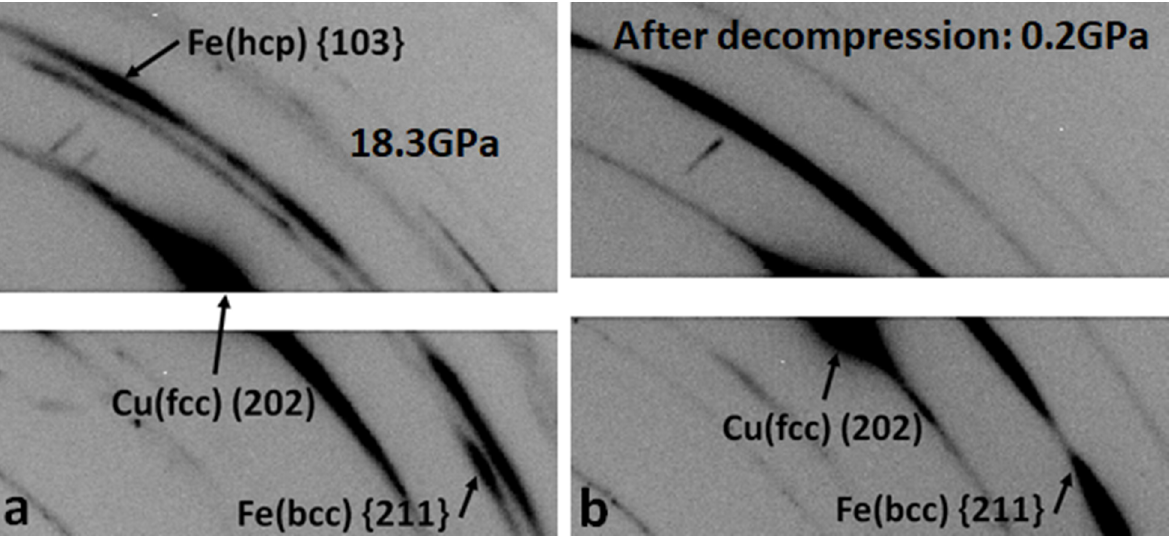
Figure 8. Diffraction patterns obtained on Cu and Fe matrices of Cu50Fe50 precipitates with X-ray monochromatic beam at 16IDB beamline of APS. Beam size 3 × 6 µm 2 ; sample was rotated by 1°. monochromatic beam at 16IDB beamline of APS. Beam size 3 × 6 µ m 2 ; sample was rotated by 1 ◦